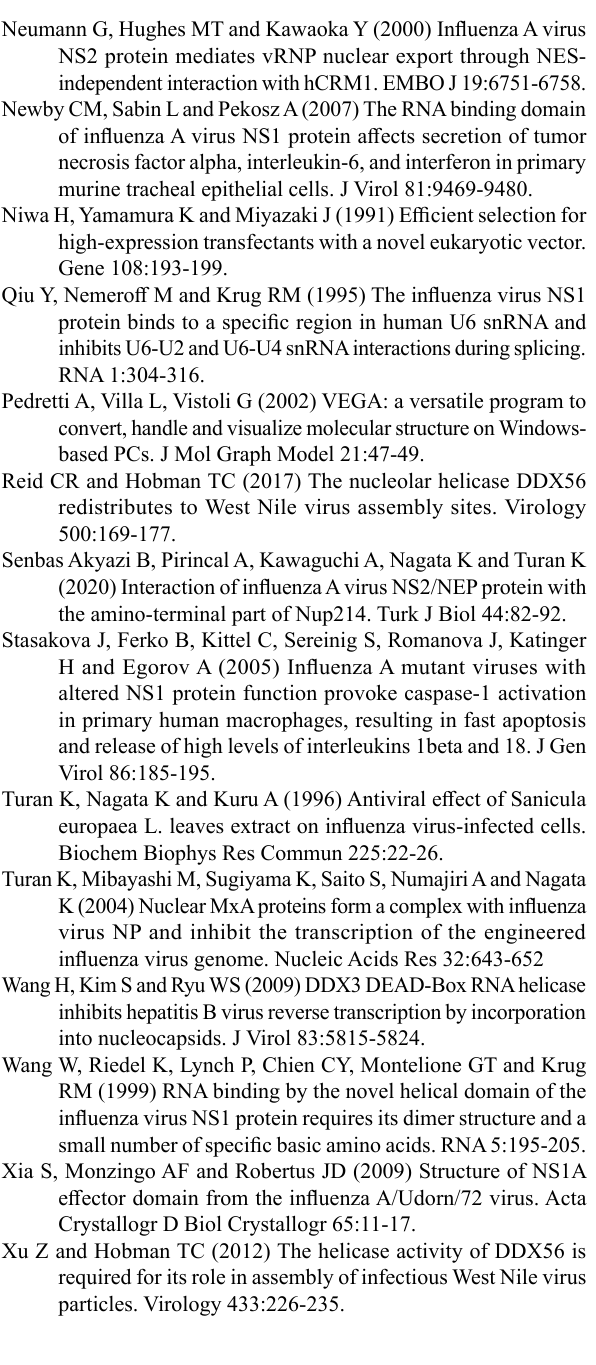
Figure S6 - The top five I-TASSER 3D models of human DDX56 protein. Figure S7 - The top five I-TASSER 3D models of influenza A virus NS1